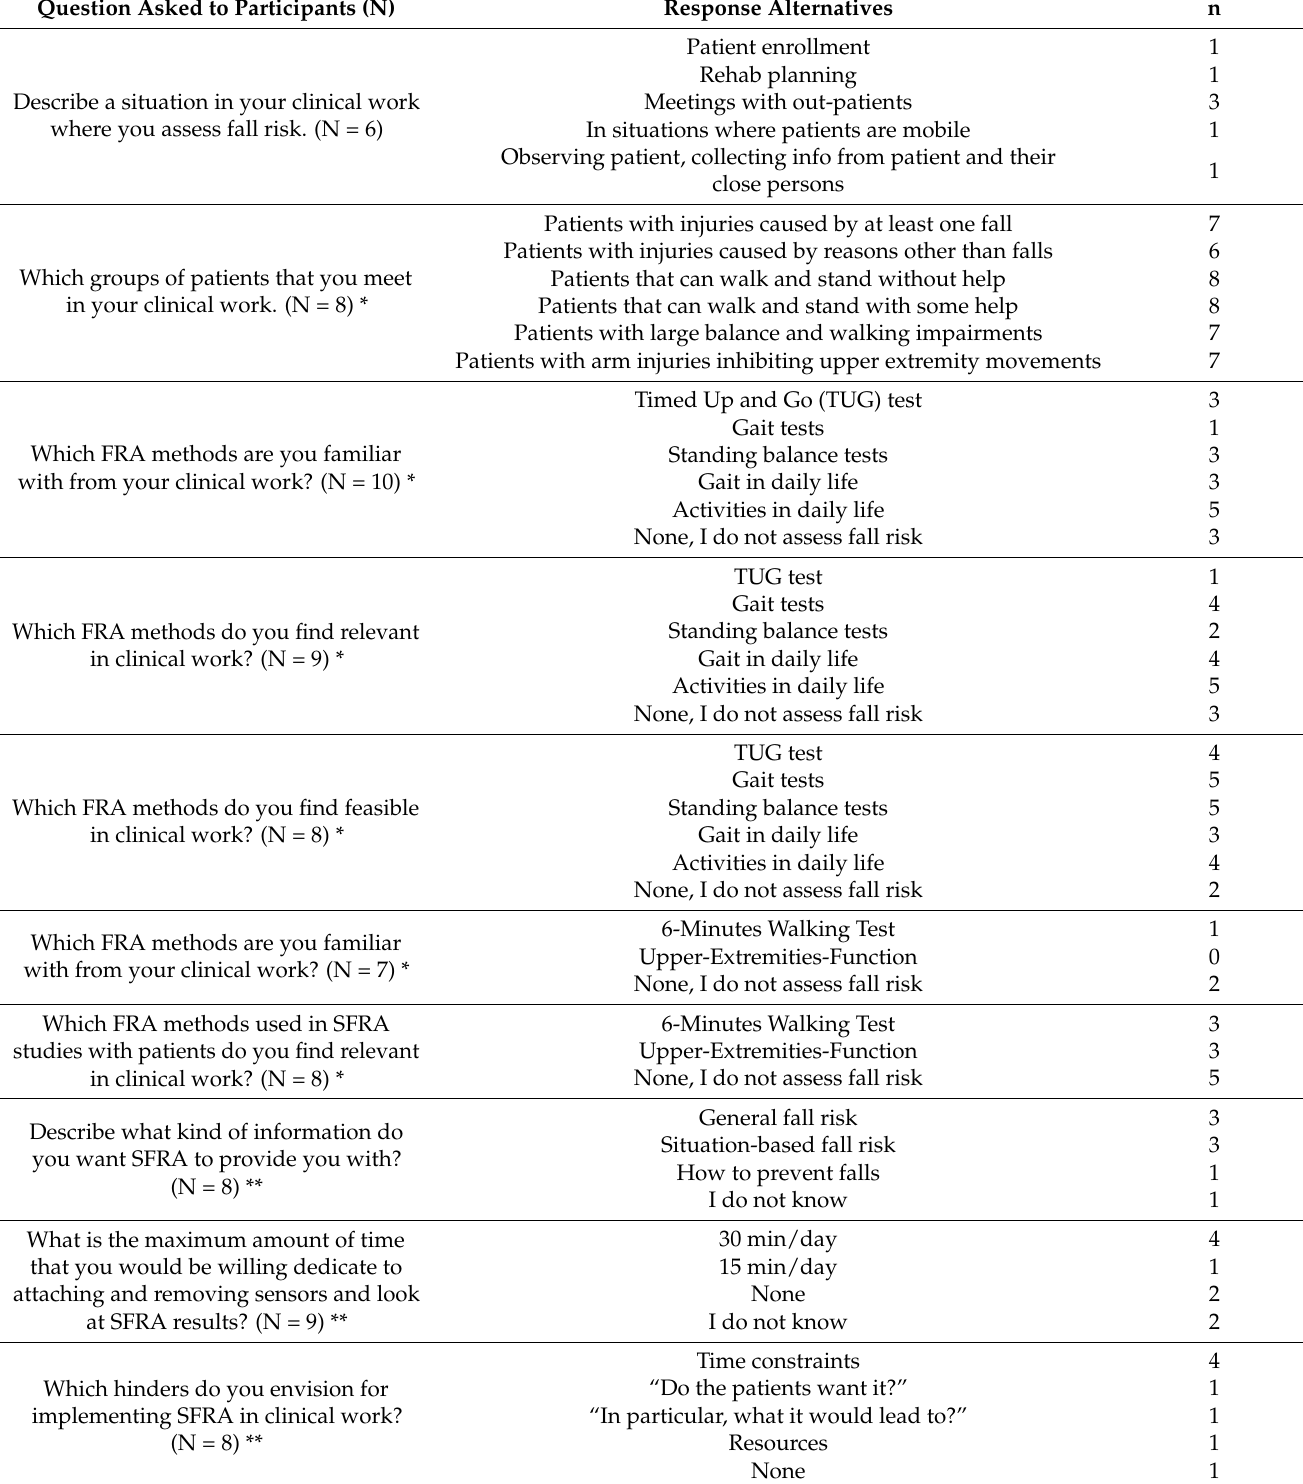
Table A1. Questions and results from the online questionnaire administered in sub-study 4 where clinical staff provided their view on the identified SFRA methods’ value for the FRA situations and the clinic’s